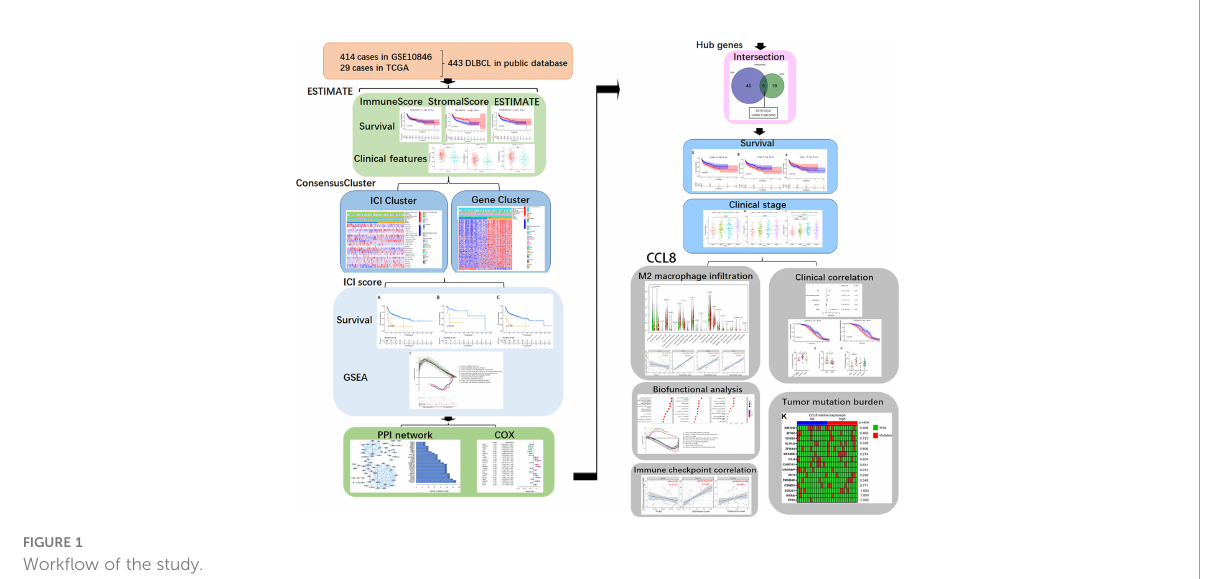
FIGURE 1 Work fl ow of the study.